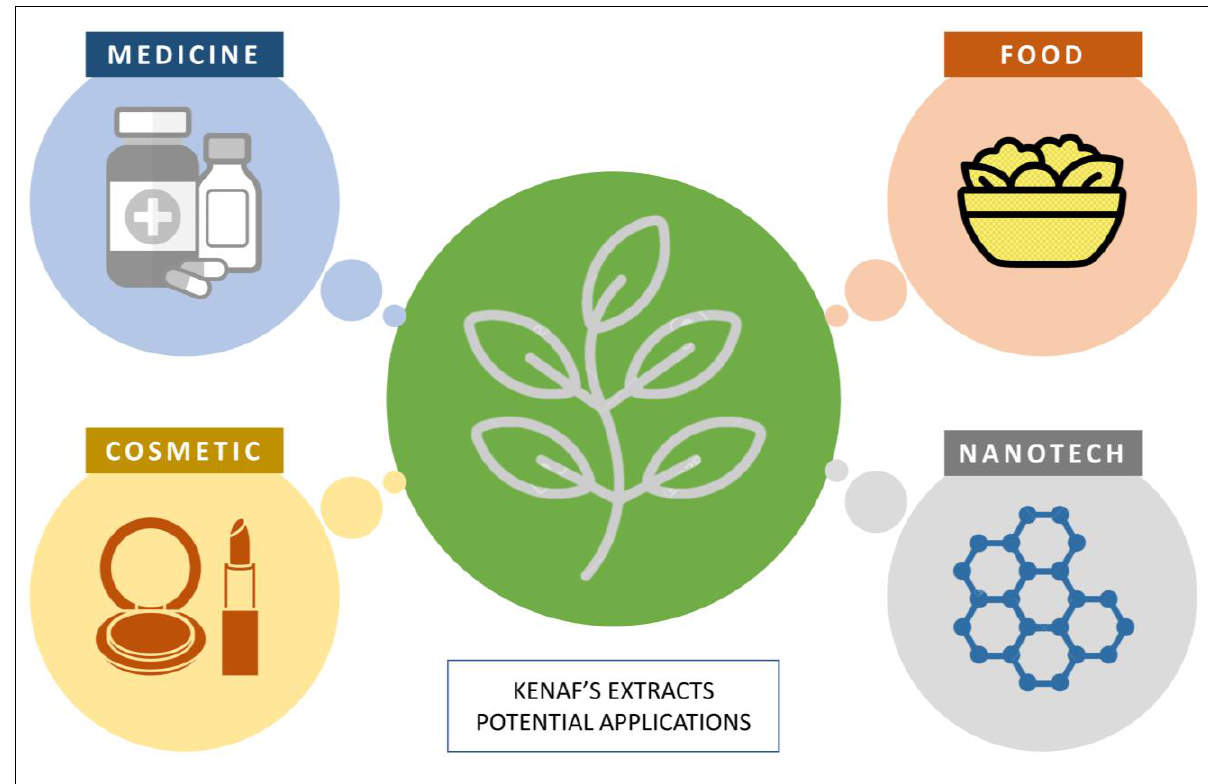
Figure 10. Kenaf extracts’ future potential applications.